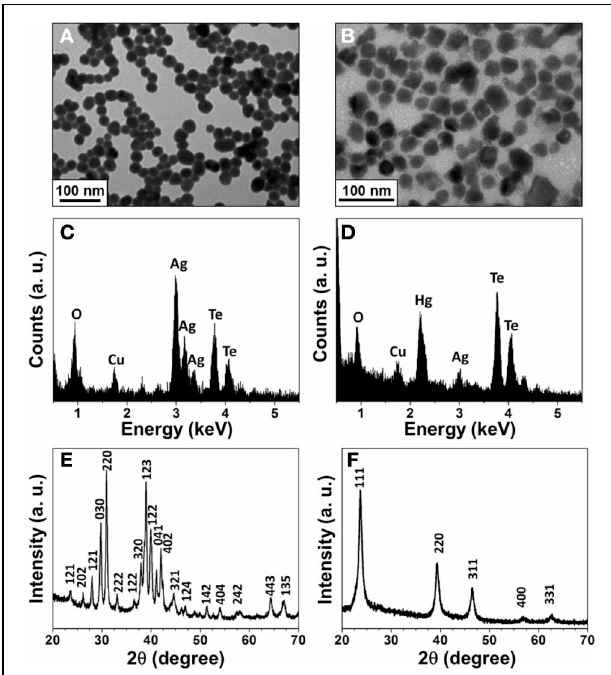
Figure 1 | Characterization of the synthesized Ag 2 Te and HgTe NPs. (A) and (B) TEM images, (C) and (D) EDAX spectra, (E) and (F) XRD spectra of Ag 2 Te and HgTe NPs, respectively. The concentrations of Ag 2 Te and Hg 2 + ions are 1 × and 5mM, respectively.